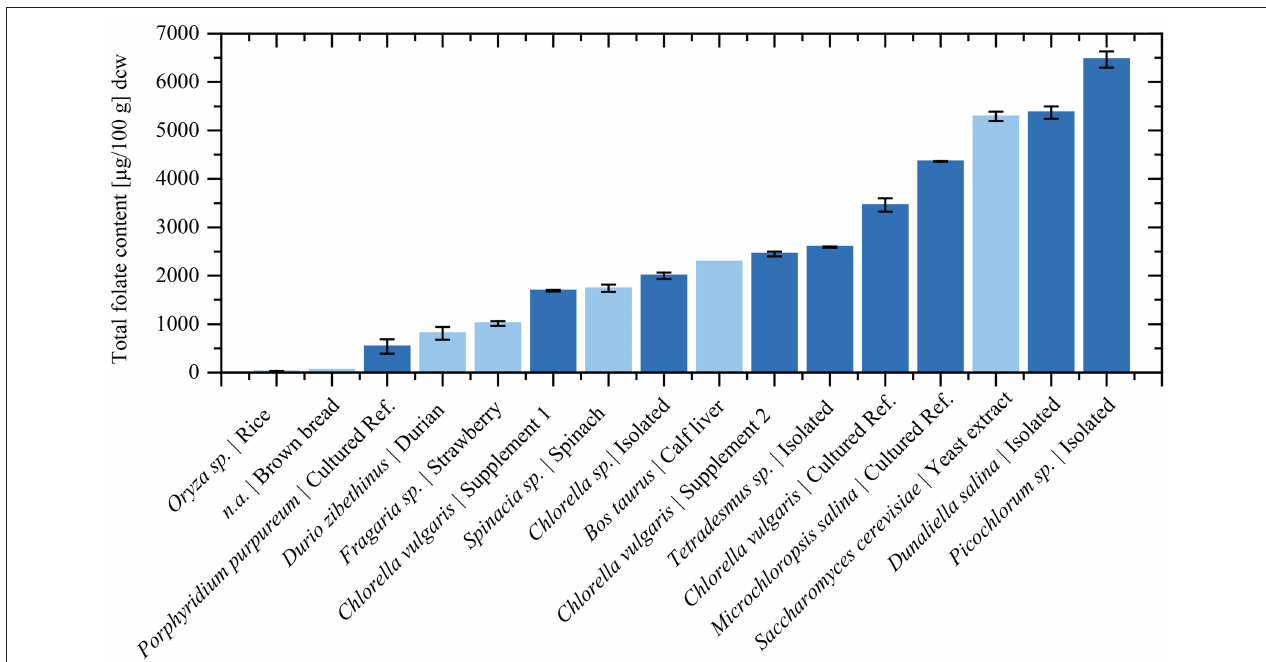
FIGURE 5 | The total folate content in selected food and algae dry biomass. Dark blue bars represent measured values from this study. The total folate content of food products was taken from previous publications using the same quantification method. The total folate contents were adapted to dry biomass according to literature values (Souci et al., 2008): Rice ( Oryza sp.) from Ringling and Rychlik (2017a), Strawberry ( Fragaria sp.) from Striegel et al. (2018b), Brown bread from Ringling and Rychlik (2013), Spinach ( Spinacia sp.) (Ringling and Rychlik, 2013), Durian ( Durio zibethinus ) from Striegel et al. (2018a), Calf liver from Ringling and Rychlik (2017a), Yeast extract from Jacob et al.